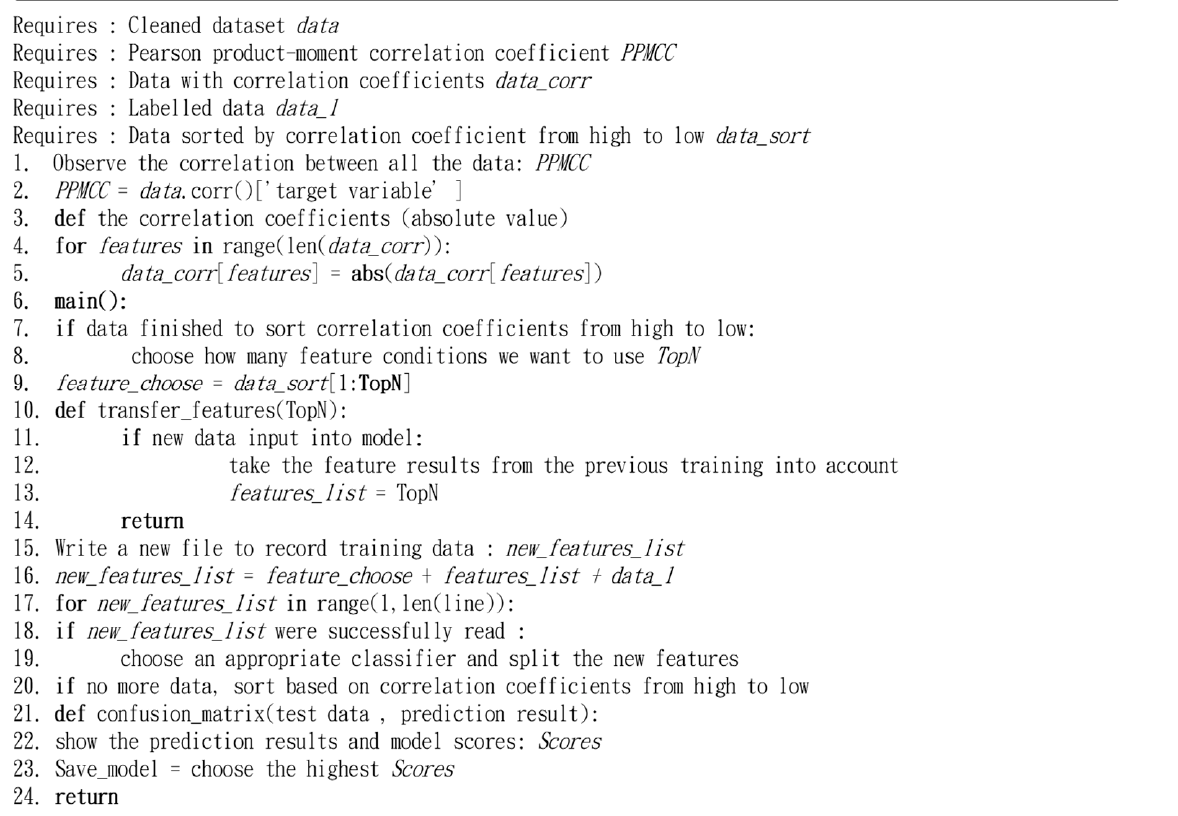
Figure 2. Pseudocode for the proposed method.